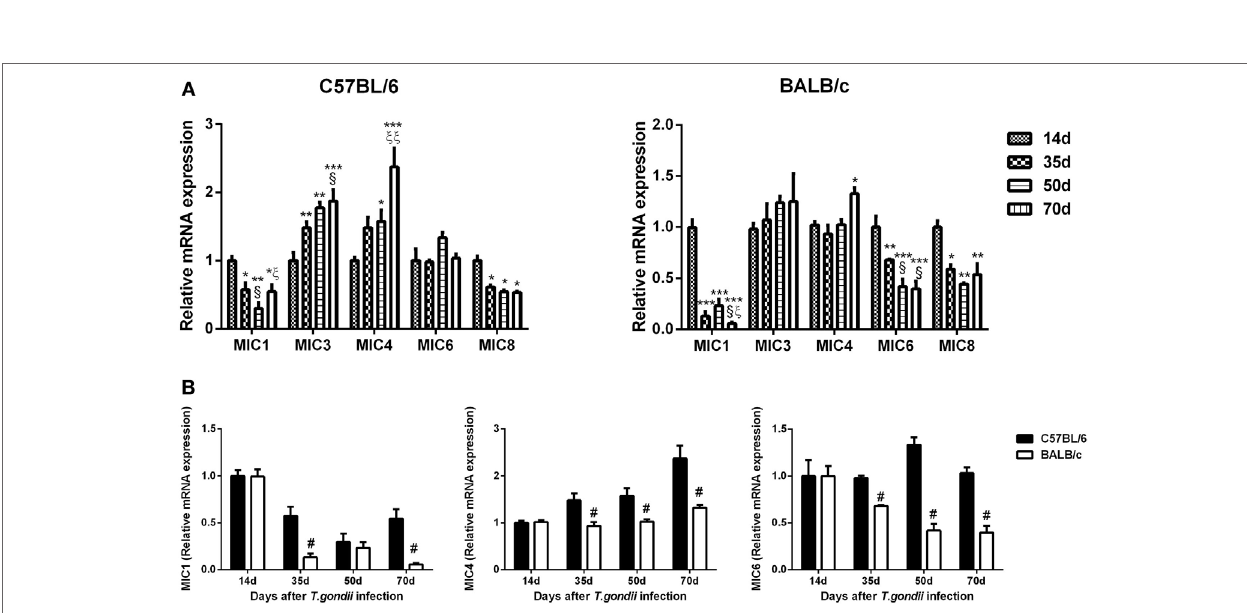
FigUre 6 | Relative mRNA expressions of TgMIC1, TgMIC4, TgMIC6, TgMIC3, and TgMIC8 in the brain tissues of Toxoplasma gondii Pru strain-infected C57BL/6 and BALB/c mice were detected by using quantitative real-time reverse transcription-polymerase chain reaction. (a) TgMICs expressions in the brains of C57BL/6 and BALB/c mice. (B) Comparison of TgMIC1, TgMIC4, and TgMIC6 levels in the brains of C57BL/6 and BALB/c mice. Transcript level at day 14 post infection (p.i.) was taken as 1. Values are means from triplicate measurements, and data are presented as mean ± SD. There were four mice per group, and data are representative of those from two different experiments. * P < 0.05, ** P < 0.01, and *** P < 0.001 vs 14 days p.i.; § P < 0.05 vs 35 days p.i.; ξ P < 0.05 and ξξ P < 0.05 vs 50 days p.i.; # P < 0.05 vs C57BL/6 mice.